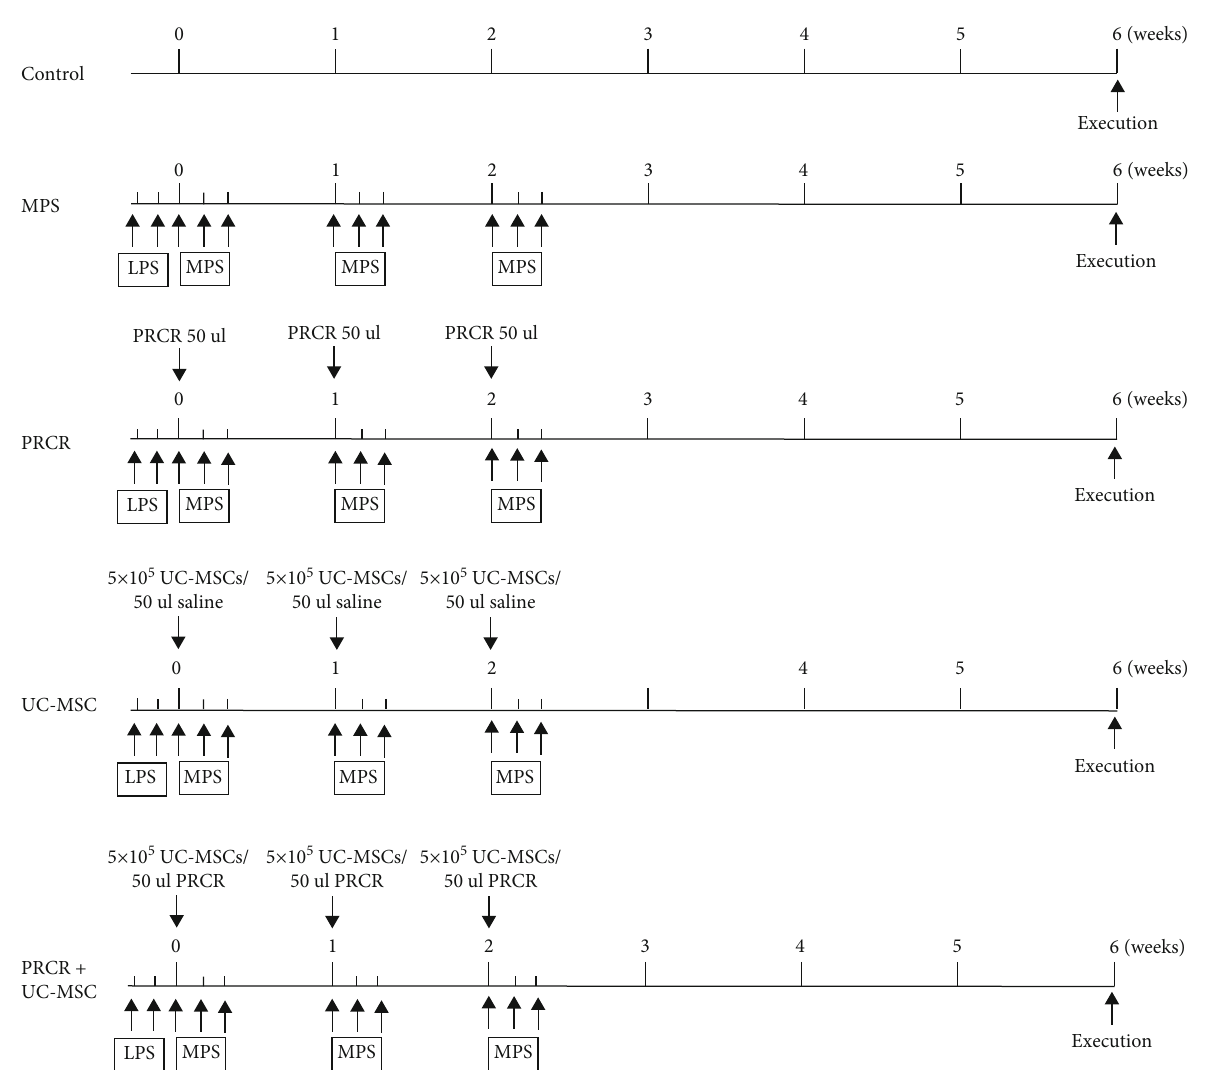
Figure 5: The time-course of animal experiments (ONFH model establishment and intra-articular injection schedule). ∗ 50 μ L injected for each hip joint. PRCR: platelet-rich plasma clot releasate; UC-MSCs: umbilical cord mesenchymal stem cells; LPS: lipopolysaccharide (LPS); MPS: